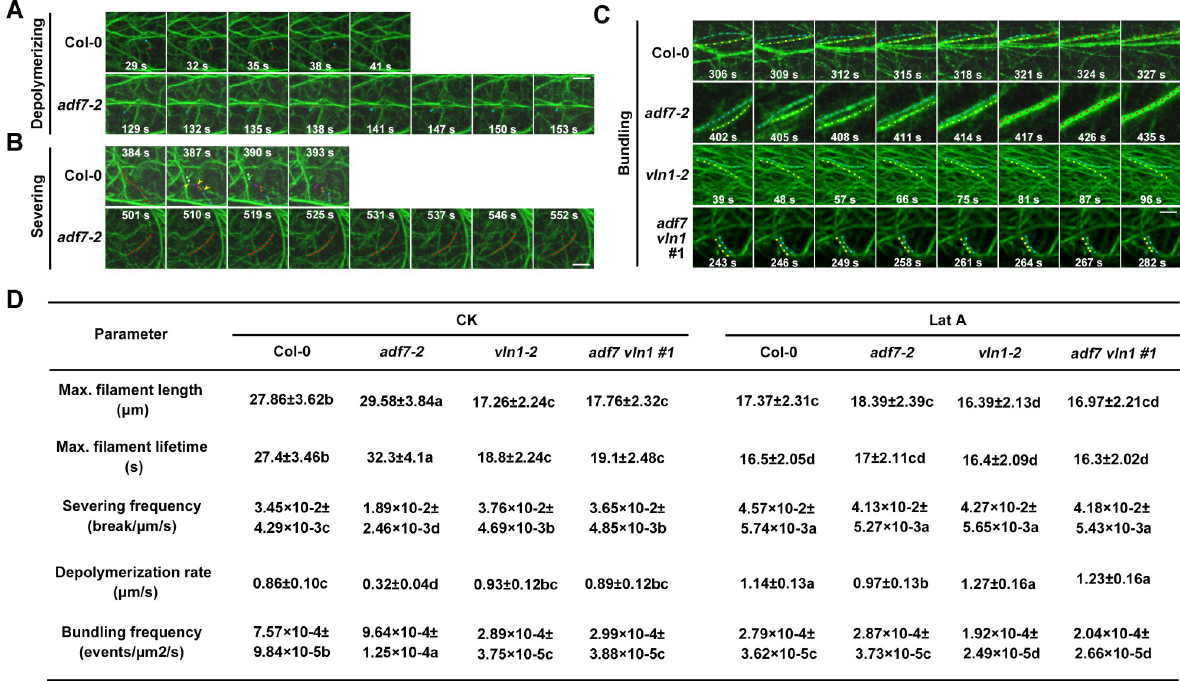
Fig 4. The F-actin dynamics regulated by ADF7-inhibited-VLN1 on single filament level in epidermal cells of root apices. (A) Depolymerizing processes in Col-0 and adf7-2 seedlings. Scale bar, 10 μ m. (B) Severing processes in Col-0 and adf7-2 seedlings. Scale bar, 10 μ m. (C) Bundling processes in Col-0, adf7-2 , vln1-2 , and adf7 vln1 #1 seedlings. Scale bar, 10 μ m. (D) The parameters of actin dynamics regulated by ADF7 and VLN1 on single actin filament level in epidermal cells of root spices under normal conditions and Lat A treatments. To analyze the bundling frequency, a 30 × 30 μ m 2 region was selected, At least 60 root cells from at least 20 individual seedlings are calculated in every genotype. Significant difference ( P < 0.05) indicated by different letters among genotypes is determined for each condition by one-way ANOVA followed by Tukey’s test.